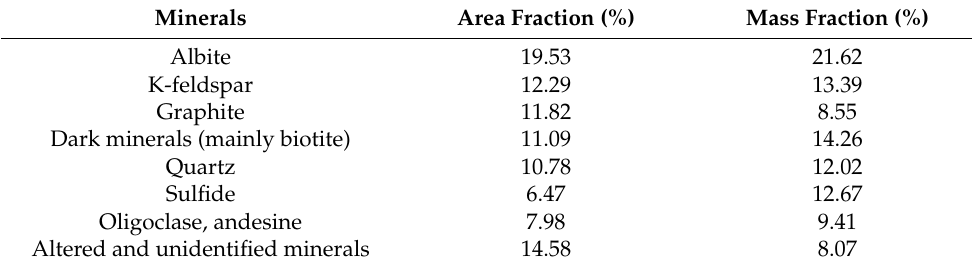
Table 1. Contents of the main minerals in the orbicular graphite ore analyzed by QEMSCAN testing.